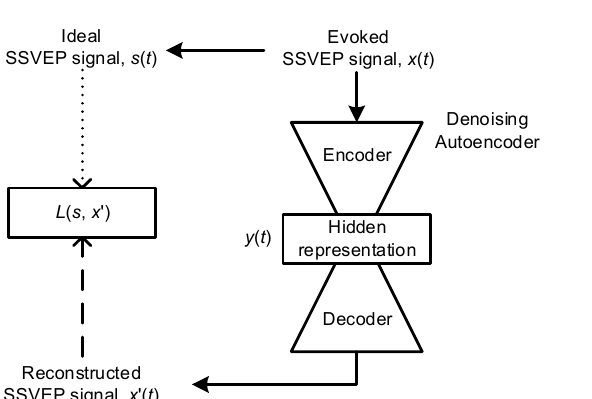
Figure 2. The flowchart of denoising autoencoder-based neural networks for robust feature extrac- tion.